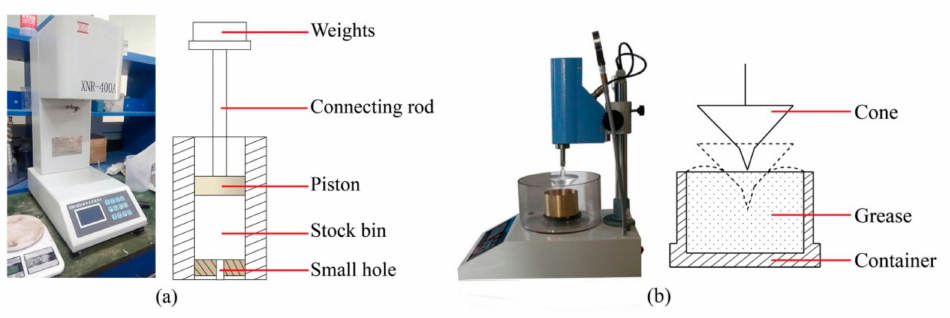
Figure 4. ( a ) Test method of melt flow rate meter; ( b ) Test method of cone